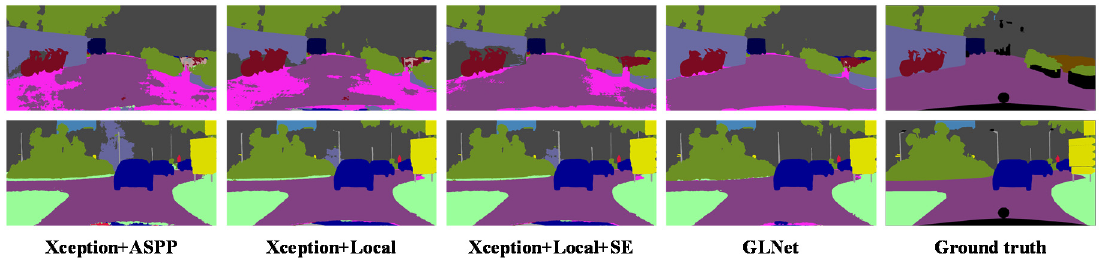
Figure 7. Visualization results on Cityscapes val. set. Refer to Table 1 for descriptions of corresponding modules.